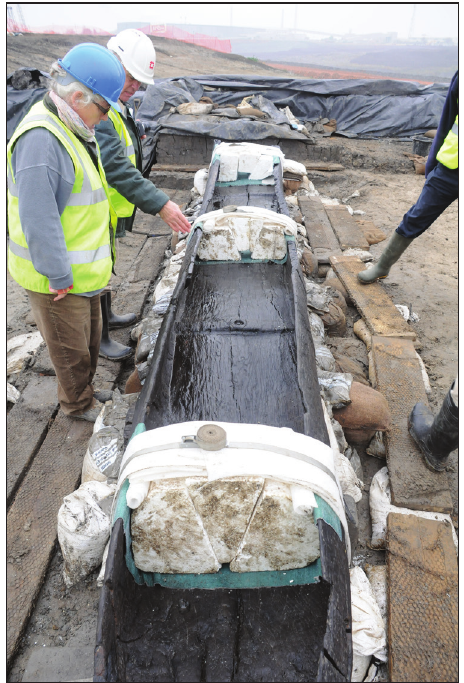
Figure 2: Maisie Taylor with one of the later Bronze Age dug-out boats at Must Farm, Peterborough, November 2011 (Photo: Francis